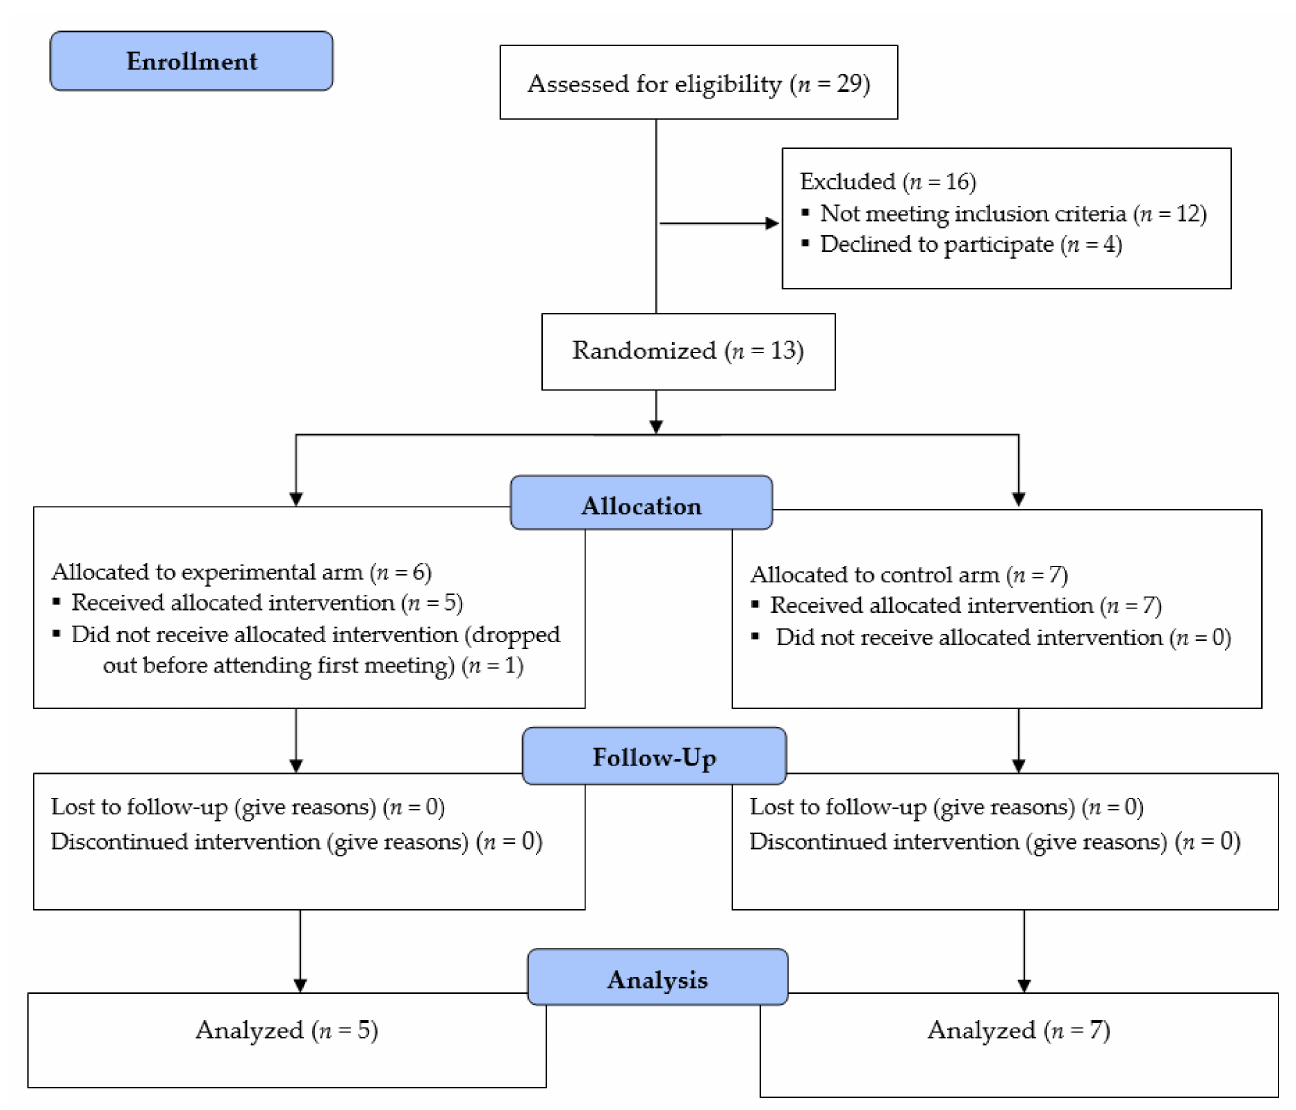
Figure 1. Study Flow